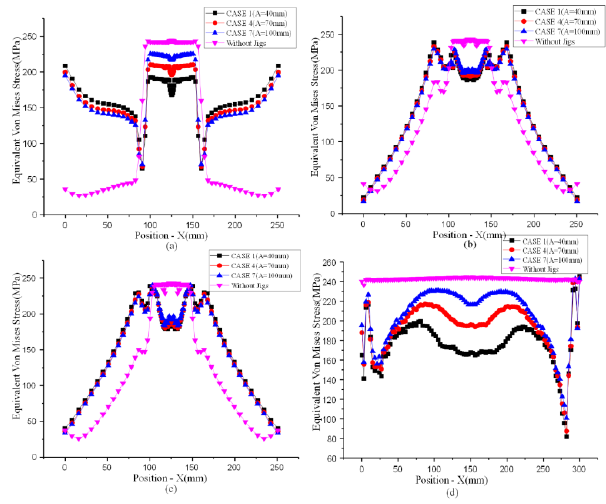
Figure 20. Residual stress distribution for ( a ) line 1, ( b ) line 2, ( c ) line 3, and ( d ) line 4.